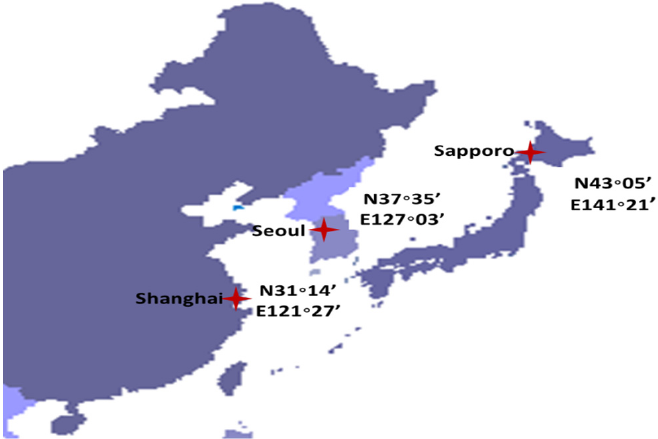
Figure 14. Location information of cities.